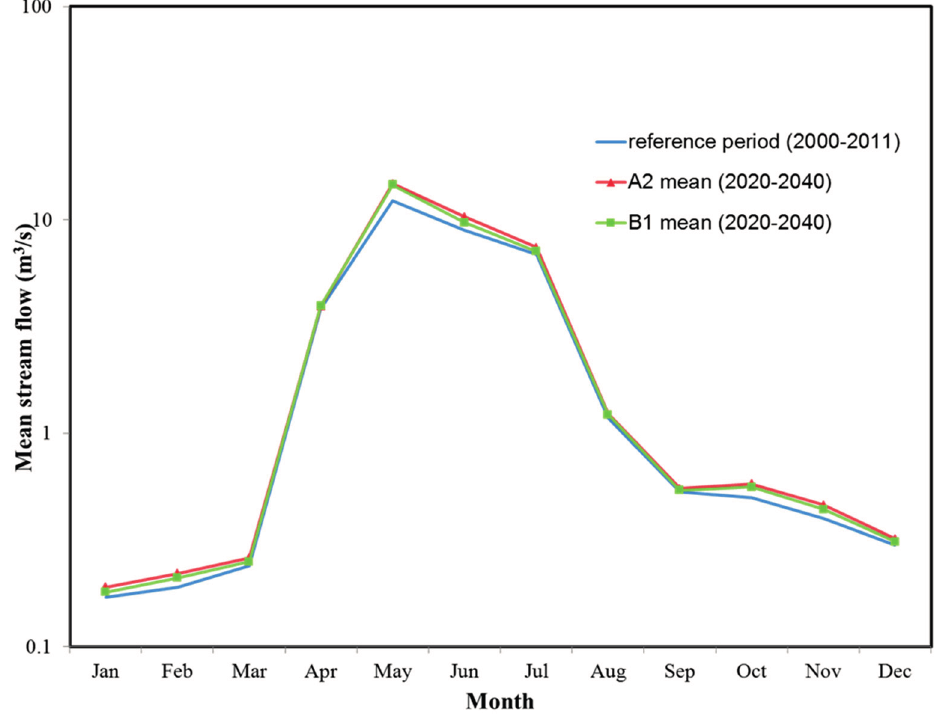
Figure 8. Comparison of mean monthly stream flow from 2020–2040 under climate change of A2 and B1 GHG emission scenarios with respect to the reference period